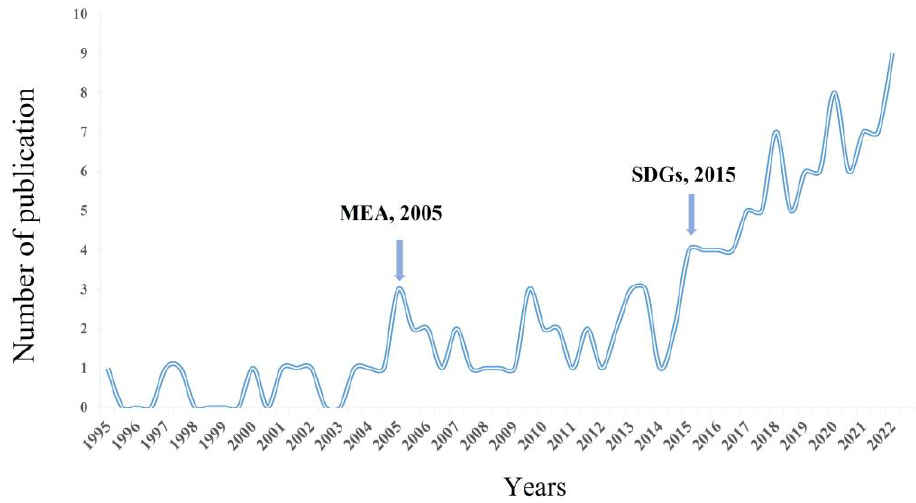
Figure 1. Trend in the annual distribution of literature related to the structure and stability of grass- land ecosystems (MEA: Millennium Ecosystem Assessment; SDGs: Sustainable Development Goals).